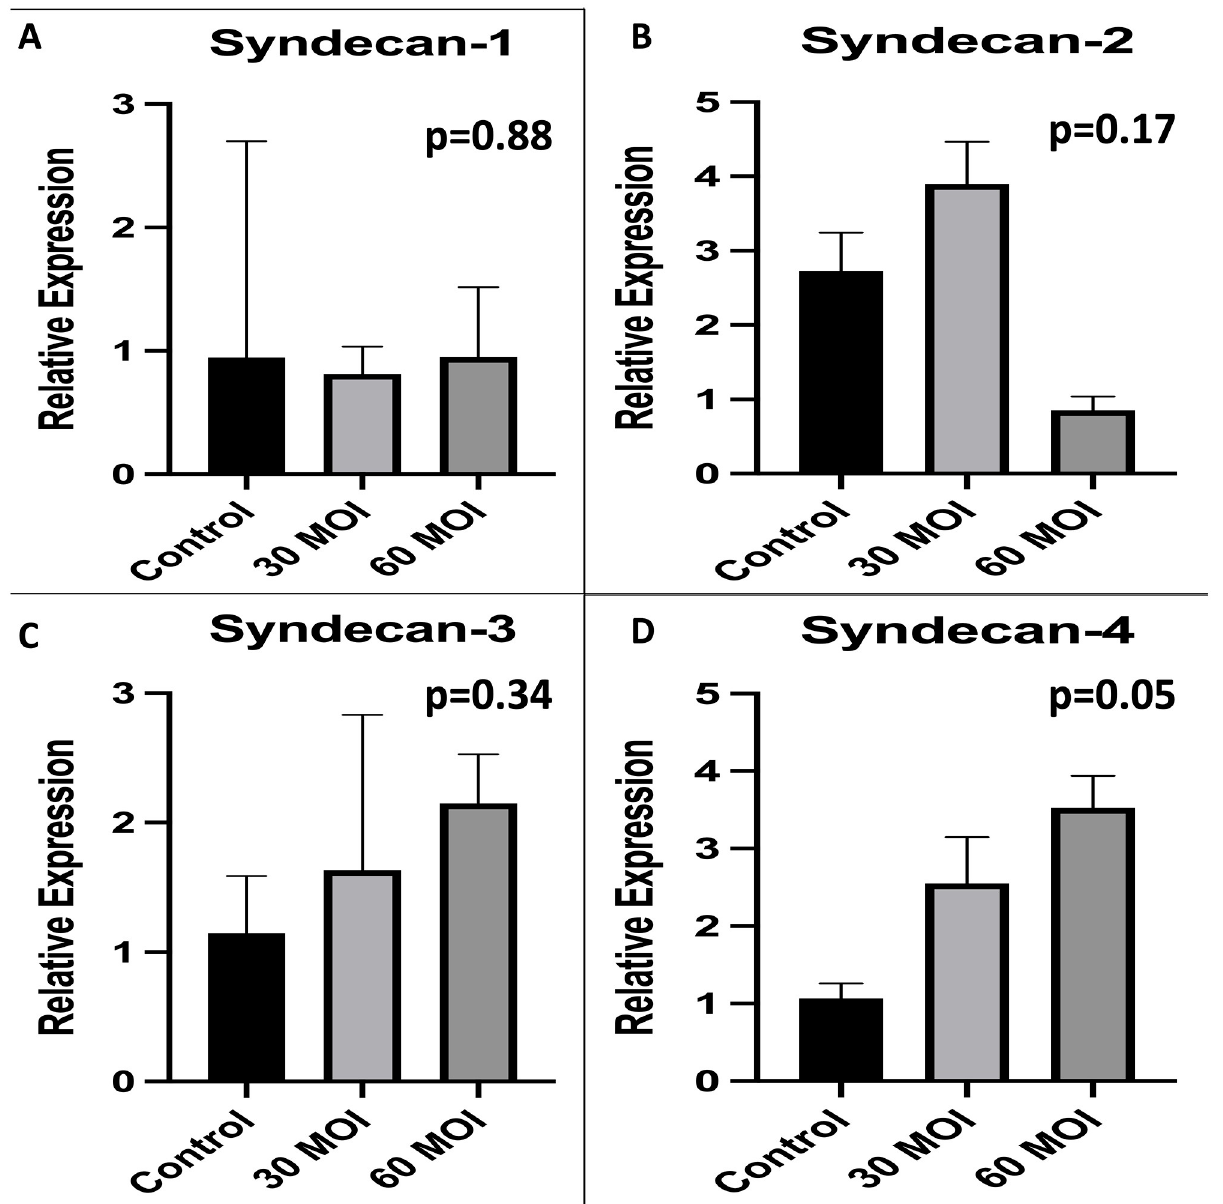
Fig 3. Comparison of syndecan levels. A comparison of syndecan expression as measured by real-time PCR demonstrating that there is no difference in A) syndecan-1, B) syndecan-2, C) syndecan-3, and 4) syndecan-4 expression when H1N1 infected human umbilical vein endothelial cells are compared to